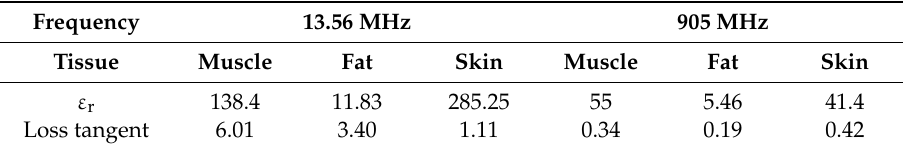
Table 2. Layered body tissue assumed electromagnetic properties at di ff erent